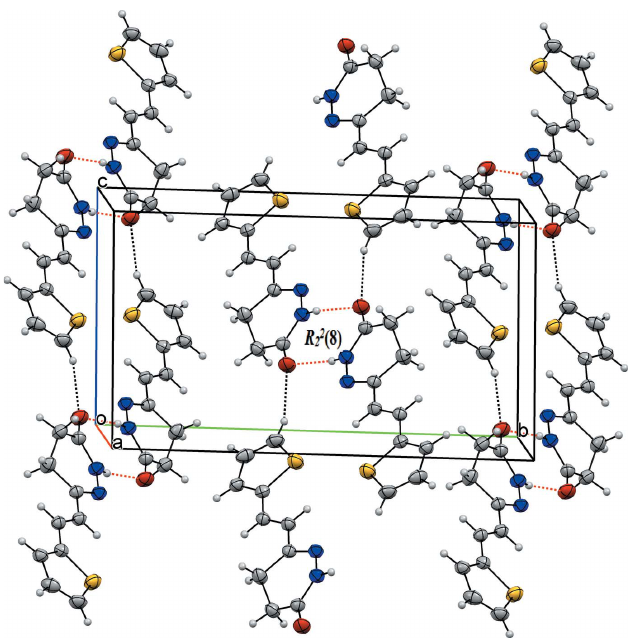
Figure 2 Inversion dimers with R 2 (8) ring motifs formed by N—H (cid:2)(cid:2)(cid:2) O hydrogen 2 bonds (red dashed lines; Table 2). C—H (cid:2)(cid:2)(cid:2) O interactions are shown as black dashed lines.